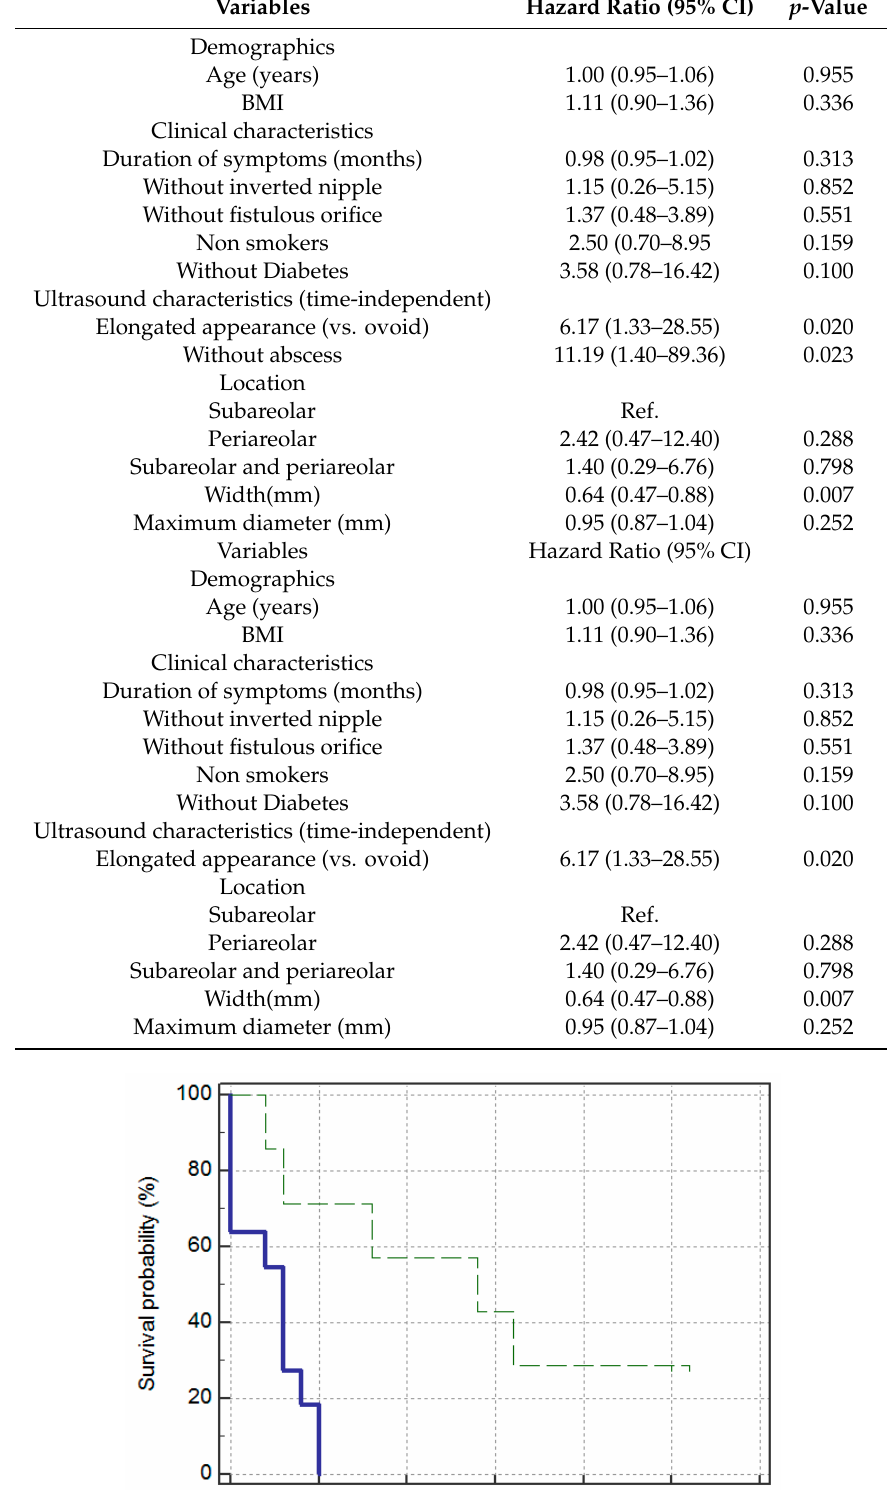
Table 2. Predictors of time to remission of the fistula (without relapse within six months) in Cox’s proportional hazards model.